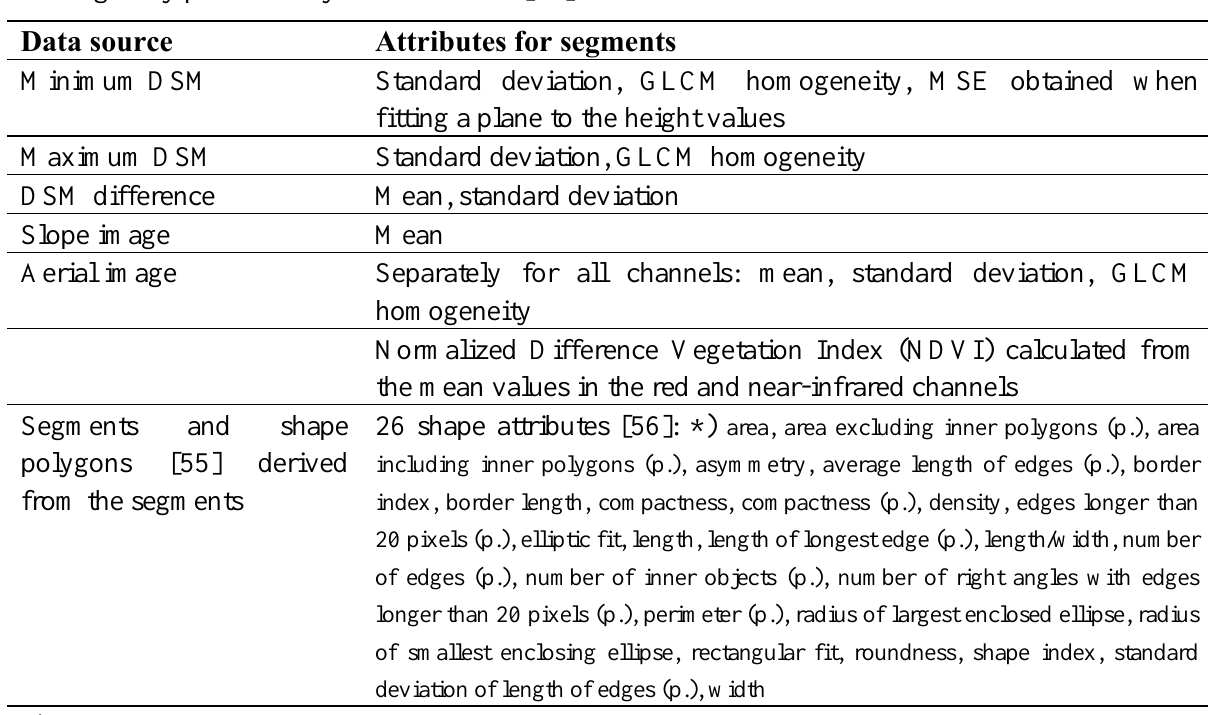
Table 1. Attributes used in the construction of the classification tree. The attributes, except the plane fitting mean squared error (MSE), were obtained from the Definiens software. The Grey Level Co-occurrence Matrix (GLCM) homogeneity is a texture measure originally presented by Haralick et al.